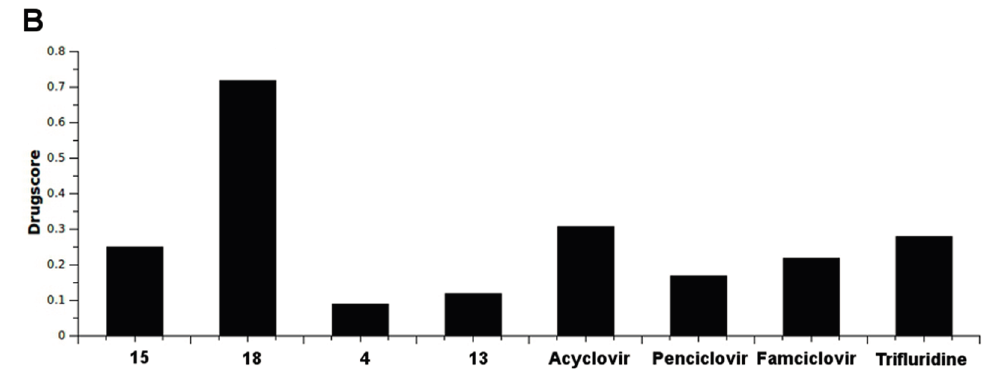
Figure 8. Results obtained from ( A ) druglikeness and ( B ) drugscore calculations. Comparison between benzoxazinones and commercial drugs against HSV shows better results for benzoxazinone 18 .